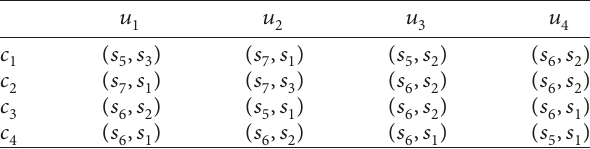
Table 2: The LPFDM for the security evaluation of computer systems.